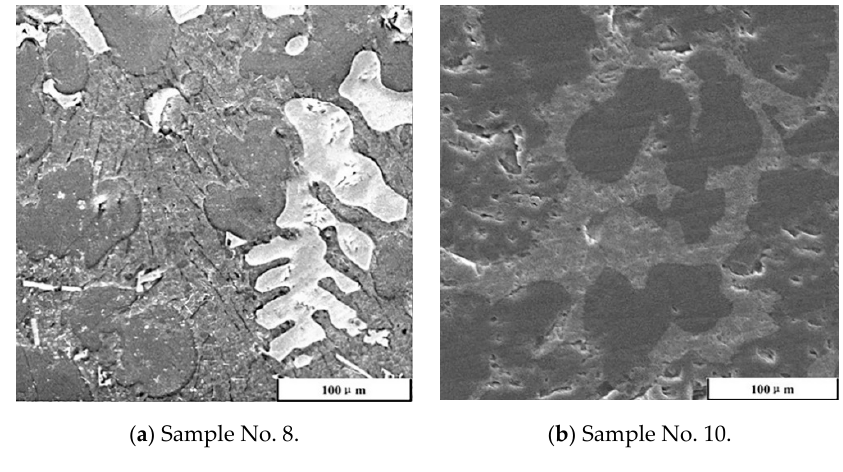
Figure 3. Photographs of samples. Table 2. Composition of the solid solution phase and liquid slag phase/wt %.